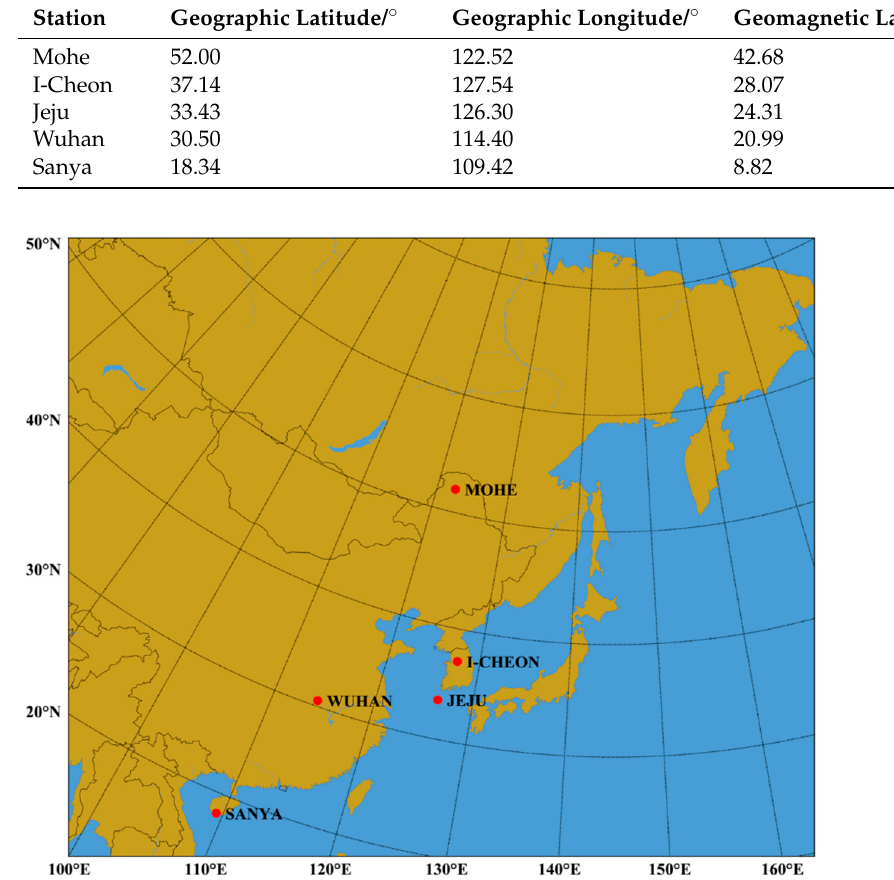
Figure 1. Geographical locations of the selected ionosondes. Table 2 lists available data of the 5 ionosonde stations, and the diagonals in Wuhan represent that there is no missing data at Wuhan. As shown in Table 2, the data of I-Cheon and Jeju ionosondes are in the period from 2009 to 2013, which are mainly distributed in low solar activity periods, and the data of Mohe, Wuhan, and Sanya ionosondes are in the period from 2013 to 2018 which covers both the high and low solar activity years. Thus, the data availabilities are different for the different ionosondes. In addition, we randomly selected 212/185/191/220/195 samples from the datasets with SF and 212/185/191/221/195